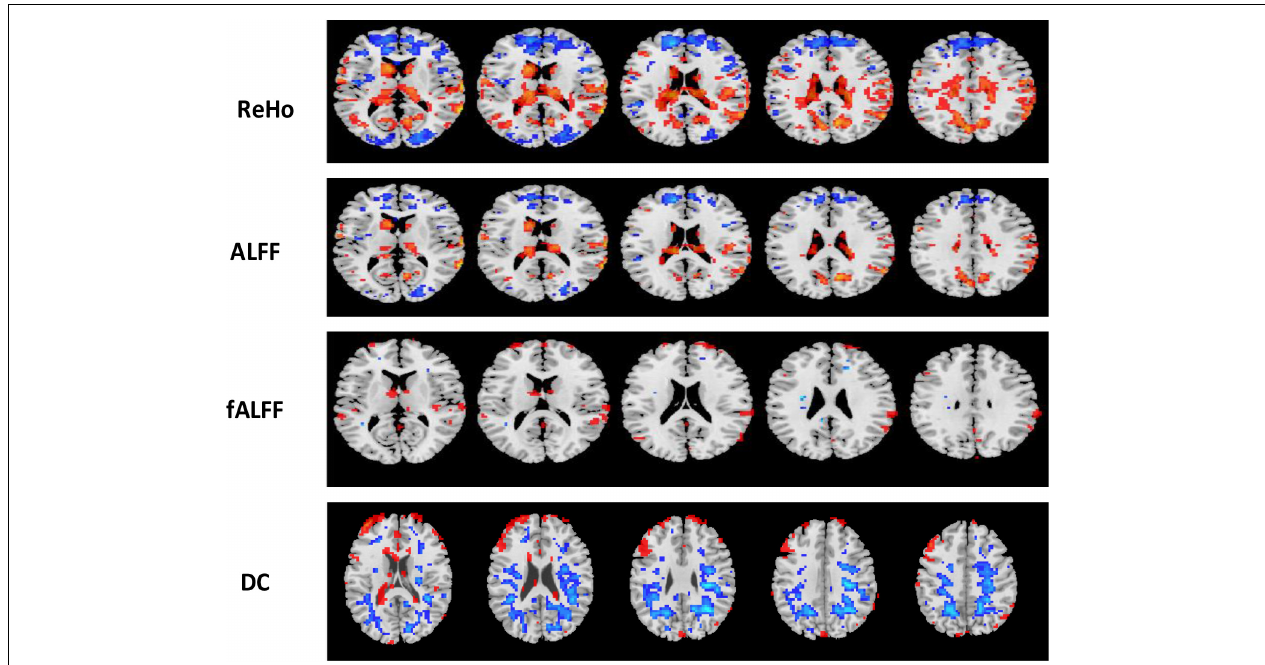
FIGURE 6 | Univariate t -test difference maps between two classification groups, AD vs. HC, of four voxel maps.